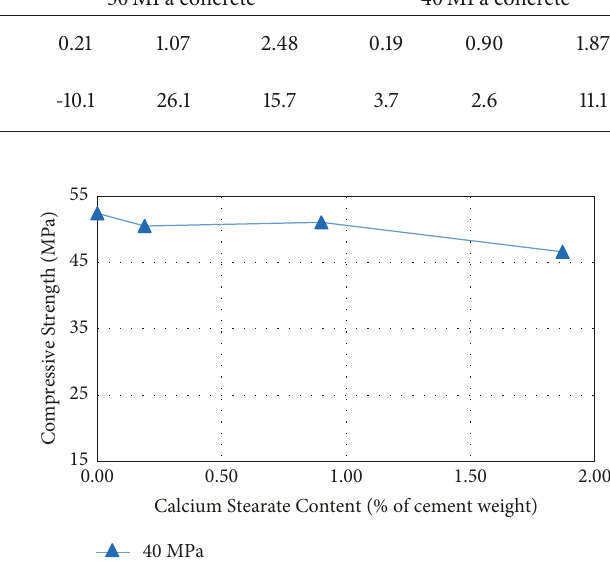
Figure 8: Compressive strength of concrete grade